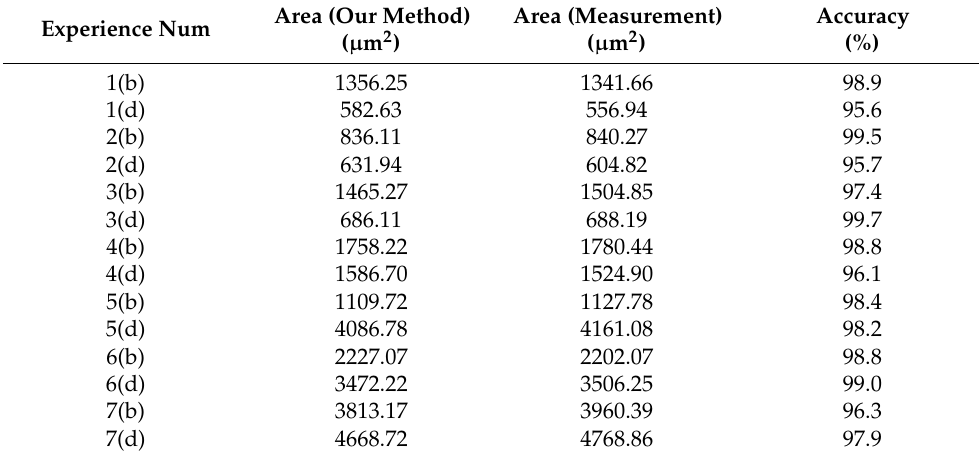
Table 2. Breakage result.